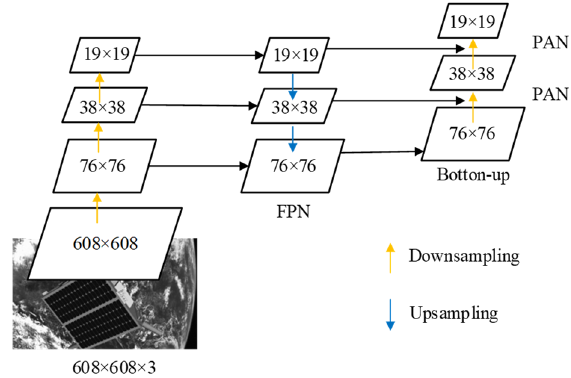
Figure 6. Neck structure.